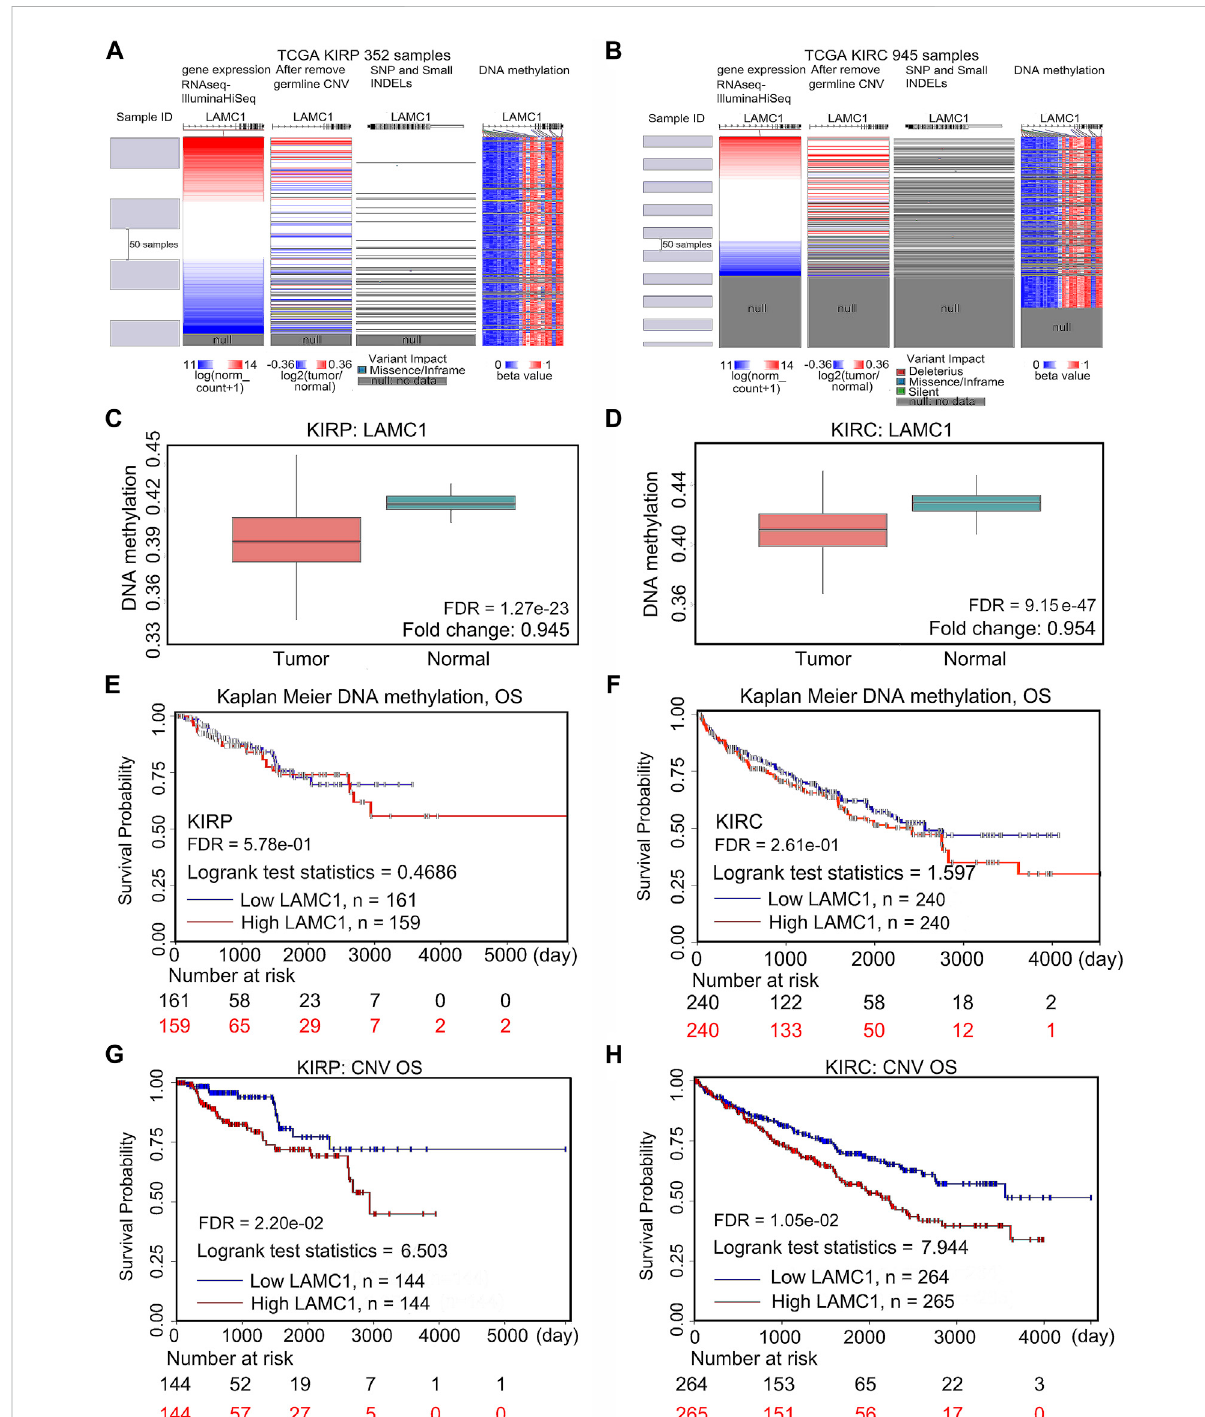
FIGURE 9 Mutation, CNV, and methylation of LAMC1 and prognostic value of the LAMC1 gene expression. (A,B) Heatmap showing the correlations between LAMC1 mRNA and somatic mutations, CNV, and methylation in KIRP (A) and KIRC (B) using UCSC Xena database. (C,D) Comparison of LAMC1 DNA methylation between normal kidney tissues and KIRP (C) and KIRC (D) tissues using survivalMeth database. (E,F) Relationship between LAMC1 DNA methylation and OS in KIRP (E) and KIRC (F) using UCSC Xena. (G,H) Relationship between LAMC1 CNV and OS in KIRP (G) and KIRC (H) using UCSC Xena. OS: overall survival; CNV: copy number